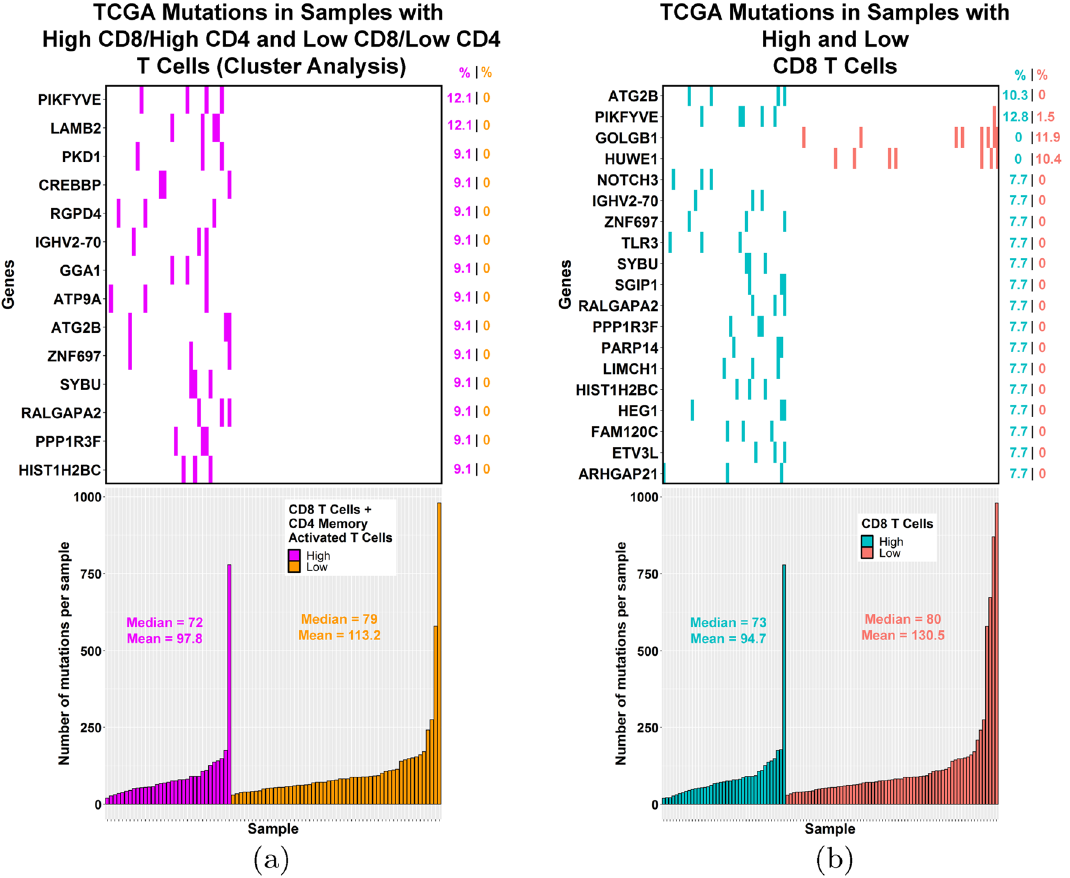
Figure 9. Genes with significantly different mutation frequencies between TCGA TNBC samples with high or low T cells (CD8/CD4 memory activated or CD8). ( a , top) 14 genes show significantly different mutation frequencies (p < 0.05, Fisher’s exact test) between the group enriched in both CD8 T cells and CD4 memory activated T cells as compared to the group low in these T cells. ( a , bottom) Mutation counts were similar between the two groups. ( b , top) 19 genes show significantly different mutation frequencies (p < 0.05, Fisher’s exact test) between the high and low CD8 T cell groups. ( b , bottom) Mutation counts were similar between the high and low CD8 T cell groups. ( a ) and ( b ) Images generated with R 4.0.2 (https ://www.R-proje ct.org) 35 .